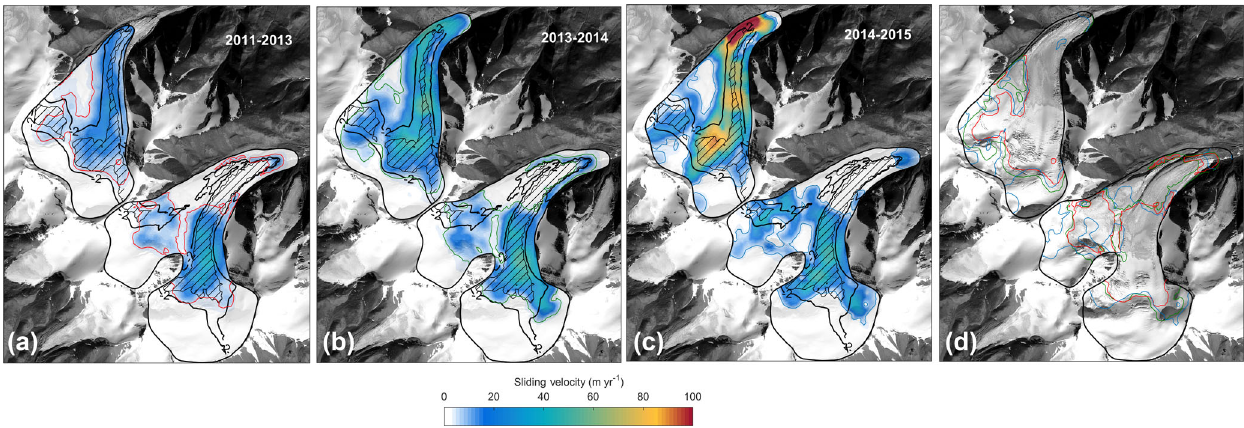
Figure 11. (a, b, c) Modelled temperate area (hatched zones) and − 2 ◦ C isotherm at steady state compared with sliding speeds over different periods (background colour map). (d) Comparison of sliding location for the different